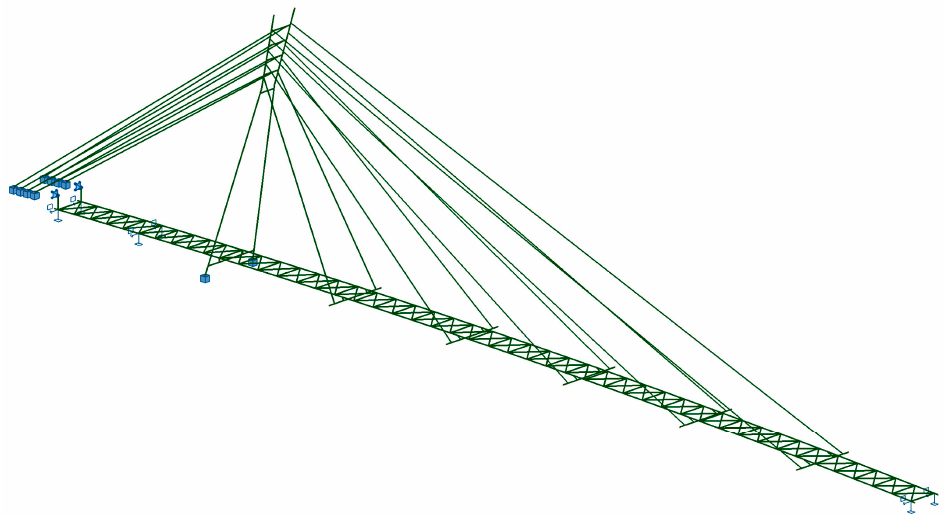
Figure 10. Numerical model of the structure.